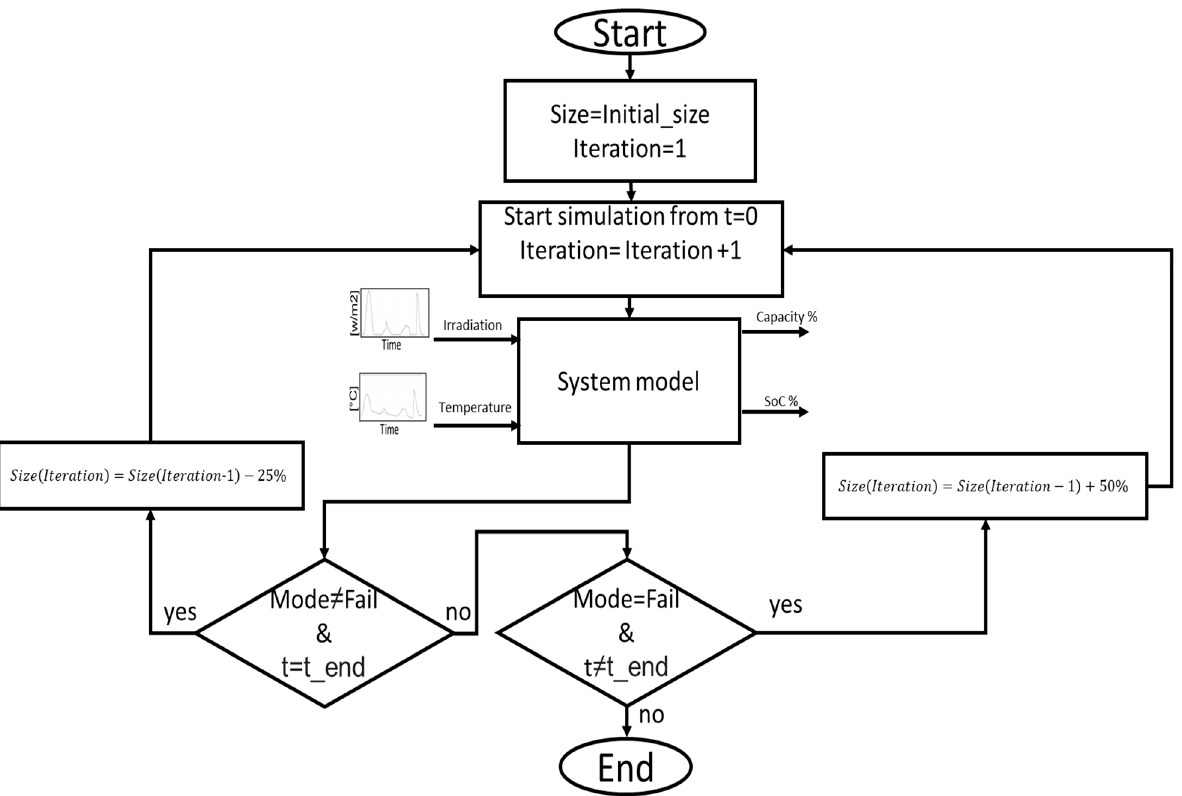
Figure 9. ES optimization algorithm using system simulation of green hydrogen production from PV.